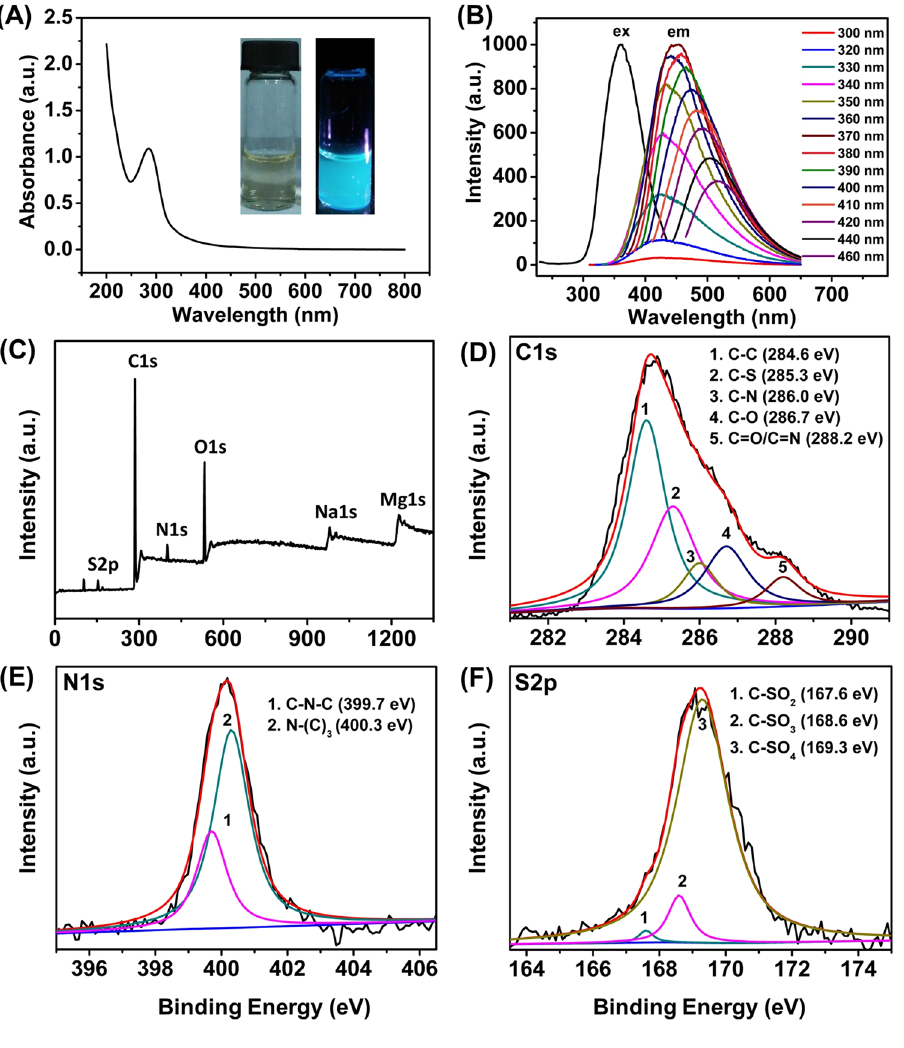
Figure 3. UV-vis absorption spectrum of CNDs. Photographs of as-prepared CNDs suspension under room light (inset, left) and upon irradiation with 365 nm UV light (inset, right). ( B ) Emission (em) spectra at progressively increasing excitation wavelengths from 300 nm to 460 nm and excitation (ex) spectrum of the CNDs suspensions. XPS spectra of the as-prepared CNDs: ( C ) Survey XPS spectrum; Narrow scan spectra of ( D ) C1s; ( E ) N1s; ( F ) S2p, respectively.